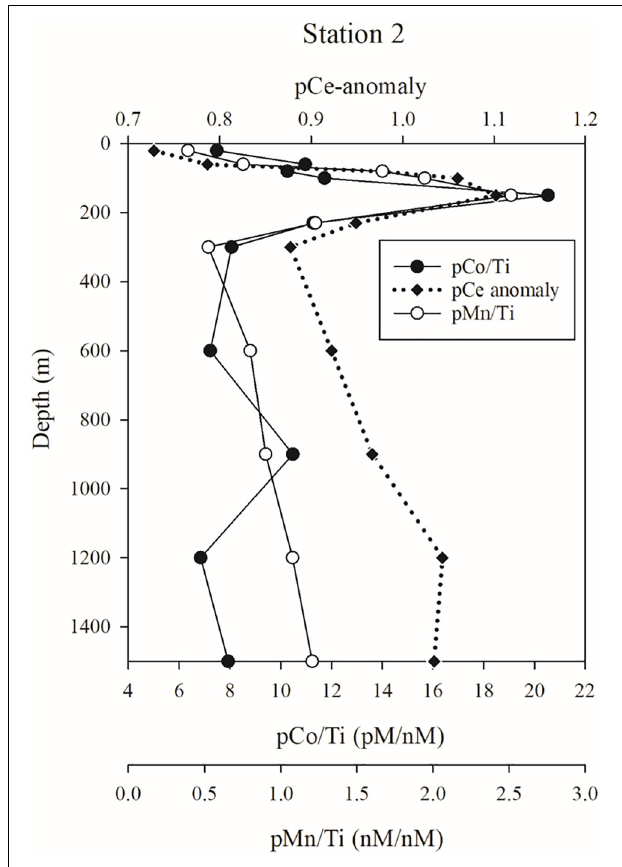
FIGURE 10 | Enrichments of particulate Mn (pMn/Ti), Co (pCo/Ti), and Ce (pCe anomaly) over crustal abundances.